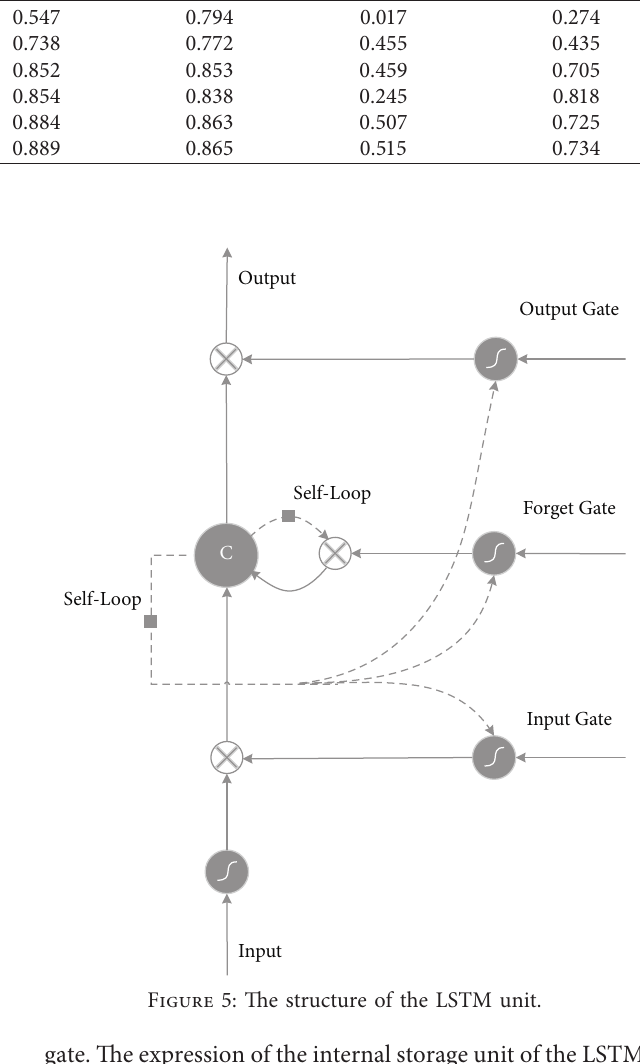
Figure 4: The ROC curve of machine learning algorithms.